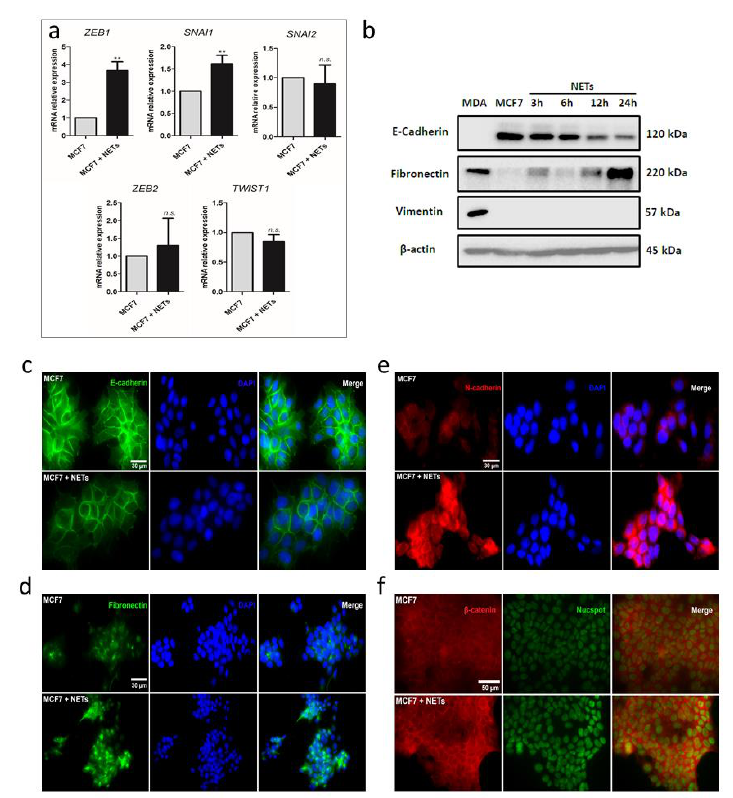
Figure 2. NETs promote epithelial–mesenchymal transition (EMT) in MCF7 cells. ( a ) Gene expression of EMT transcription factors was analyzed by quantitative RT-PCR. GAPDH was used as the reference gene. Relative expression of mRNA was calculated using the ∆∆ CT method. Columns represent means ± SD of a minimum of three independent experiments. Unpaired t -test was applied for statistical analysis. ** p < 0.01 and n.s. , no significance. ( b ) Western blot analysis of the EMT markers protein levels (E-cadherin, fibronectin, and vimentin) in MCF7 cells (1 × 10 6 ) treated with NETs (500 ng / mL) for 3 to 24 h. β -actin was used as a loading control and MDA-MB-231 (MDA) was used as a mesenchymal cell model. Representative image from two independent experiments. Immunocytochemistry analysis of ( c ) E-cadherin (green, magnification 630 × , scale bars 30 µ m); ( d ) fibronectin (green, magnification 400 × , scale bars 30 µ m); ( e ) N-cadherin (red, magnification 630 × , scale bars 30 µ m); and ( f ) β -catenin (red, magnification 630 × , scale bars 50 µ m) in MCF7 cells that were cultured for 16 h in the absence (above) or the presence (below) of NETs (500 ng / mL). Nuclei were stained with 4’,6-Diamidino-2-Phenylindole (DAPI) (blue) or NucSpot (green) and merged images are shown on the right panels. Changes in the expression pattern of E-cadherin and fibronectin were confirmed